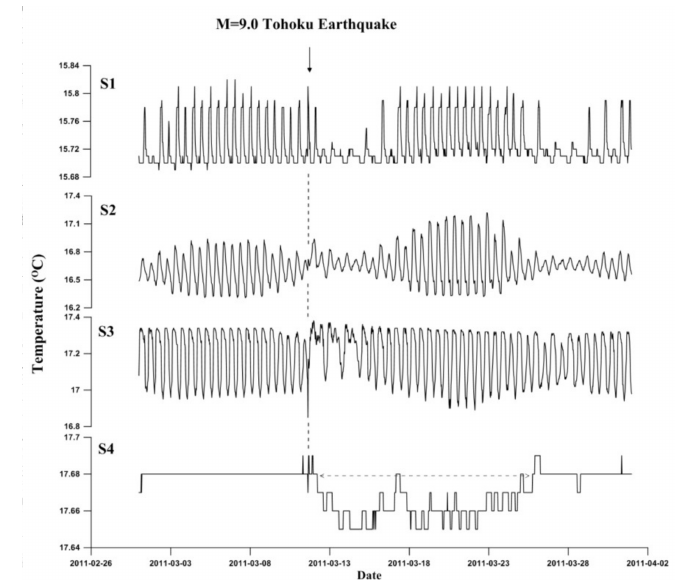
Figure 11. Vertical changes of the multi-layer temperature in the multi-depth detection system of well